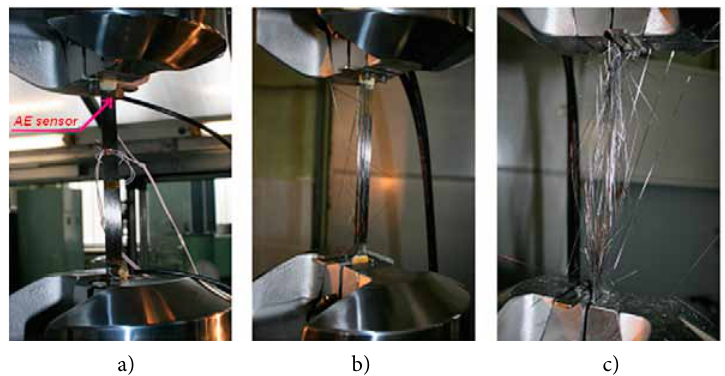
Fig. 11. The sequence of the CFRP destruction under a static loading. a – initial state; b – intermediate (the destruction of the matrix); c – final (the destruction of the